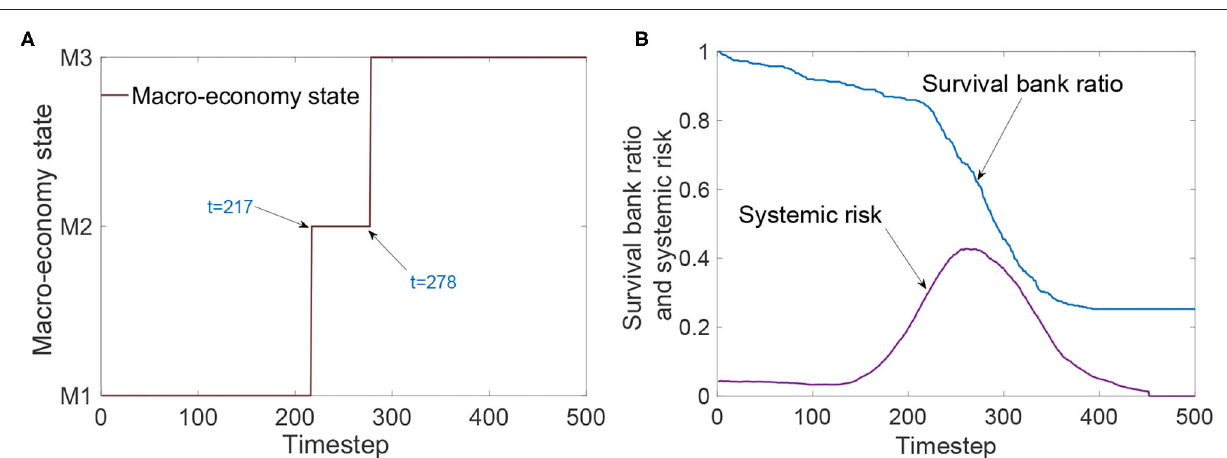
liquidity, investment opportunities, and average bank